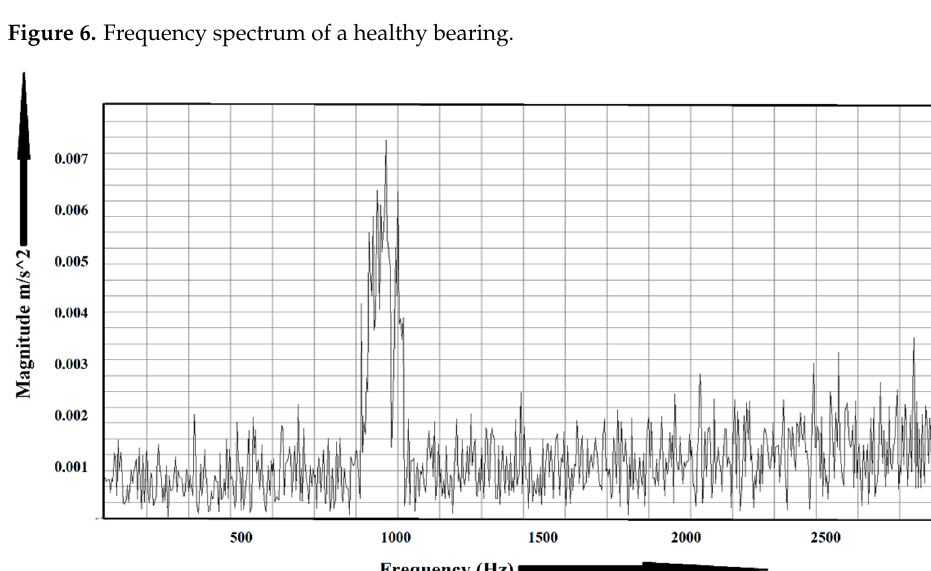
Figure 7. Frequency spectrum of a faulty bearing.